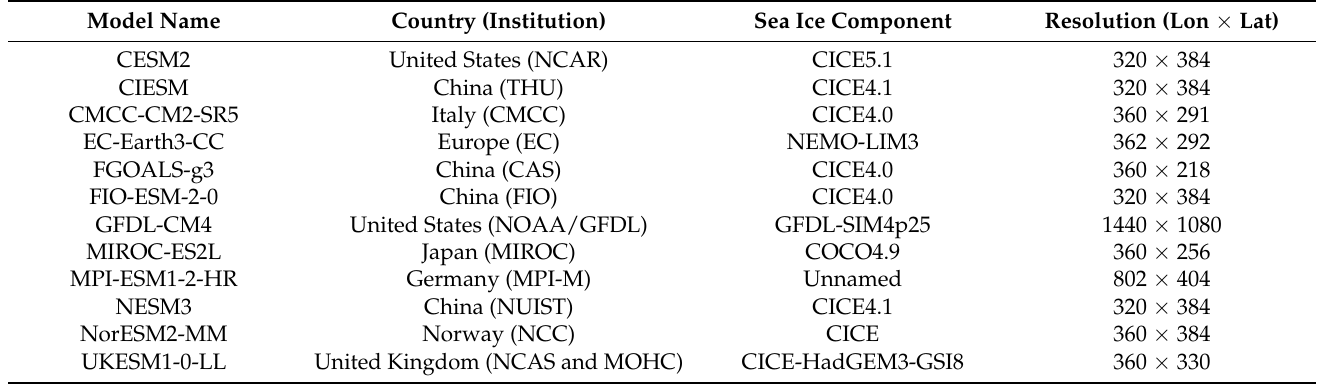
Table 1. The information of CMIP6 models used.